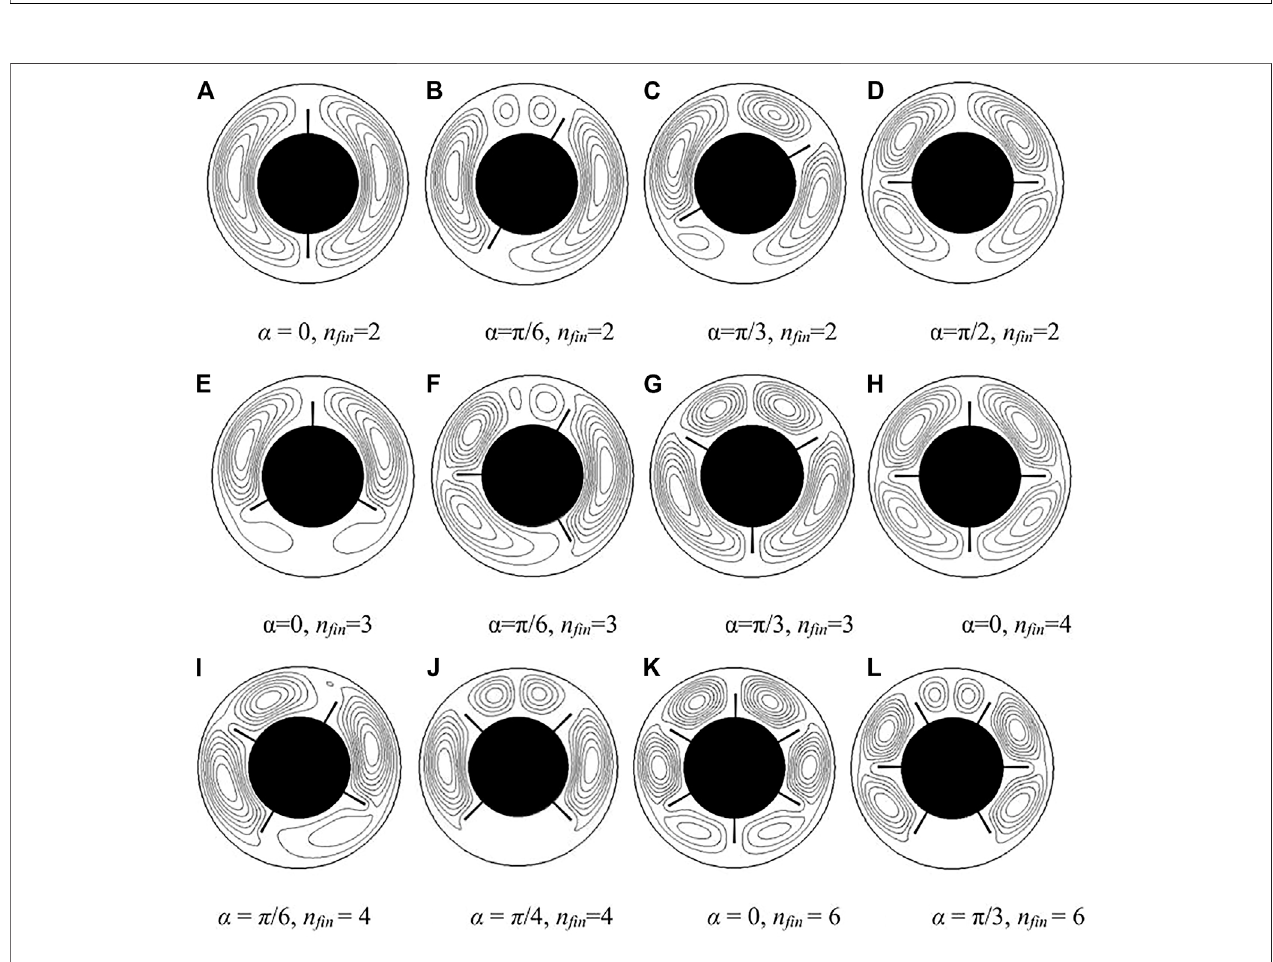
FIGURE3| Flow fi eldswith different fi nnumbers and positions forRa (cid:1) 5 × 10 3 . (A) α (cid:1) 0, n fi n (cid:1) 2 (B) α (cid:1) π /6, n fi n (cid:1) 2 (C) α (cid:1) π /3, n fi n (cid:1) 2 (D) α (cid:1) π /2, n fi n (cid:1) 2 (E) α (cid:1) 0, n fi (cid:1) 3 (F) α (cid:1) π /6, n fi (cid:1) 3 (G) α (cid:1) π /3, n fi n n (cid:1) 6 (L) α (cid:1) π /3, n fi (cid:1) 6. Ra , Rayleigh number; α , angle of fi ns; n fi n